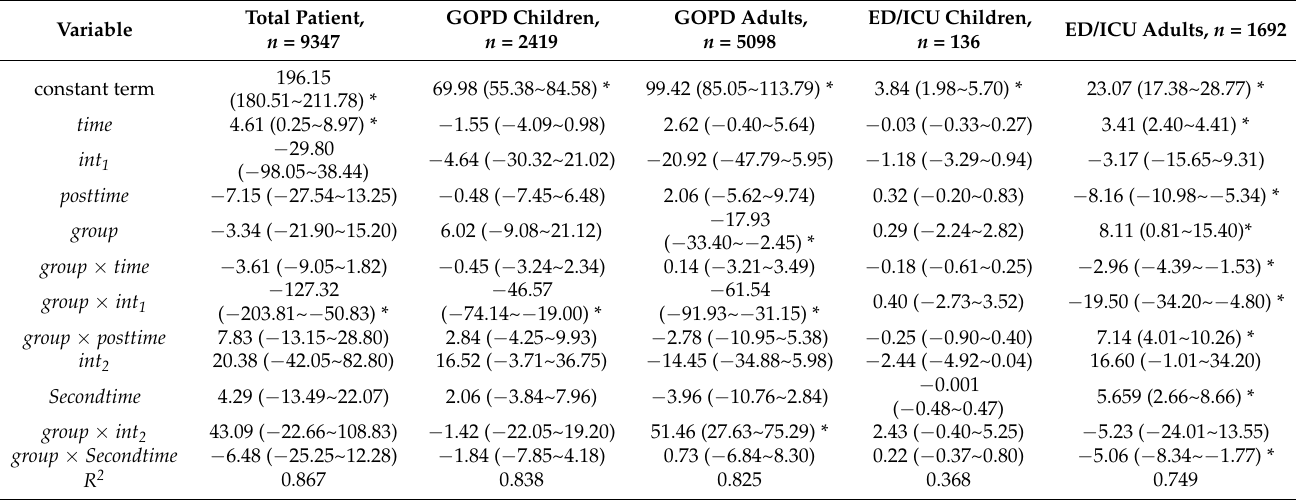
Table 2. CITS analysis of asthma-related hospital and outpatient visits per week before and after COVID-19 preventions [parameter estimates (95%CI)].